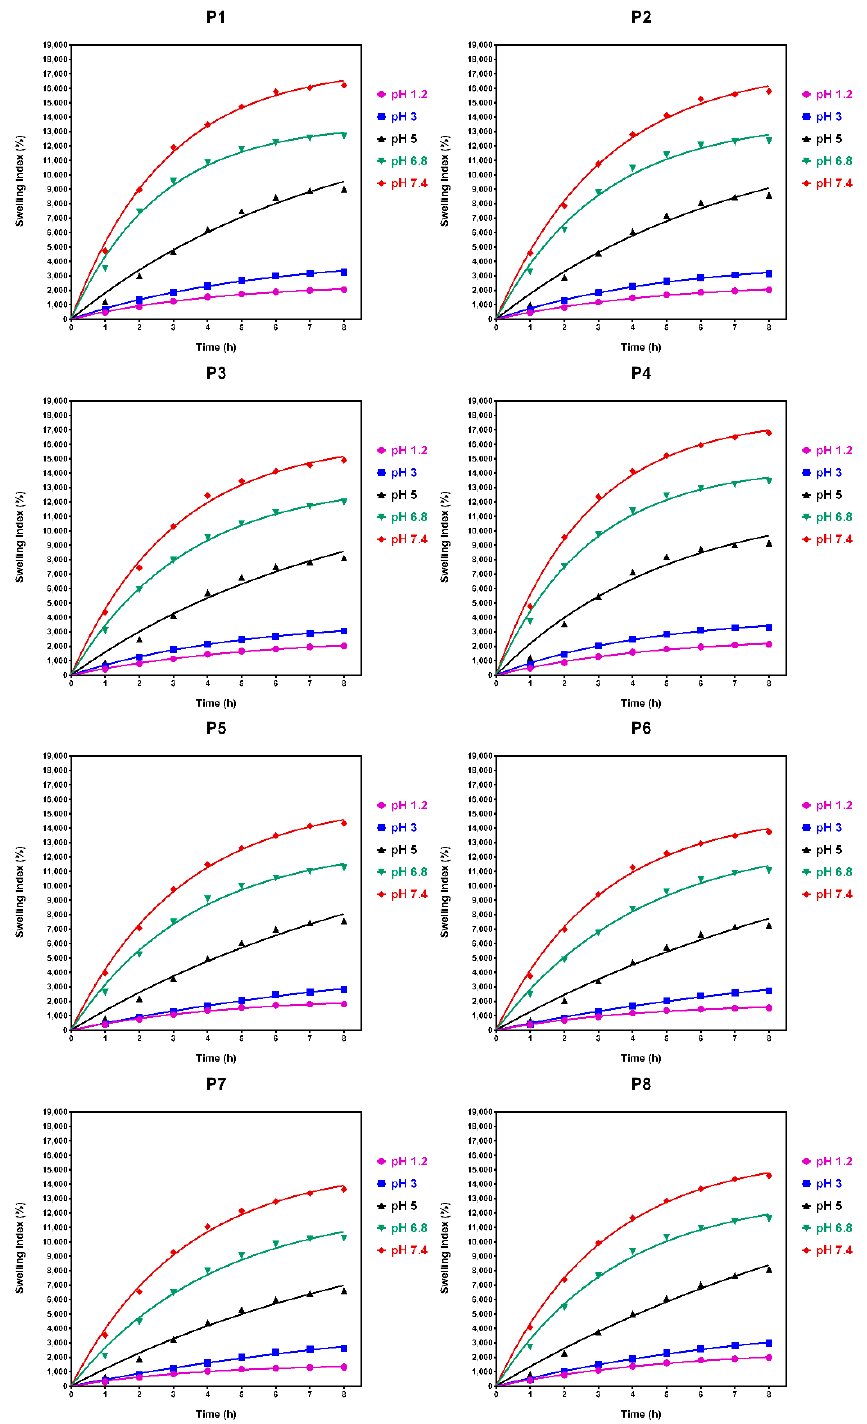
Figure 15. Graphical comparisons of the results of the nonlinear regression of the idxSWL (%) time series for samples P1–P8 and all pH factor levels.